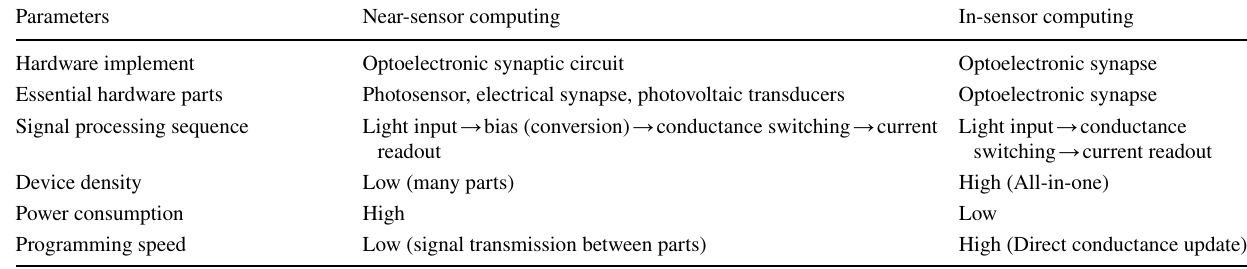
Table 1 Characteristic summary of neuromorphic vision sensors for near‑sensor and in‑sensor computing Parameters Near‑sensor computing In‑sensor